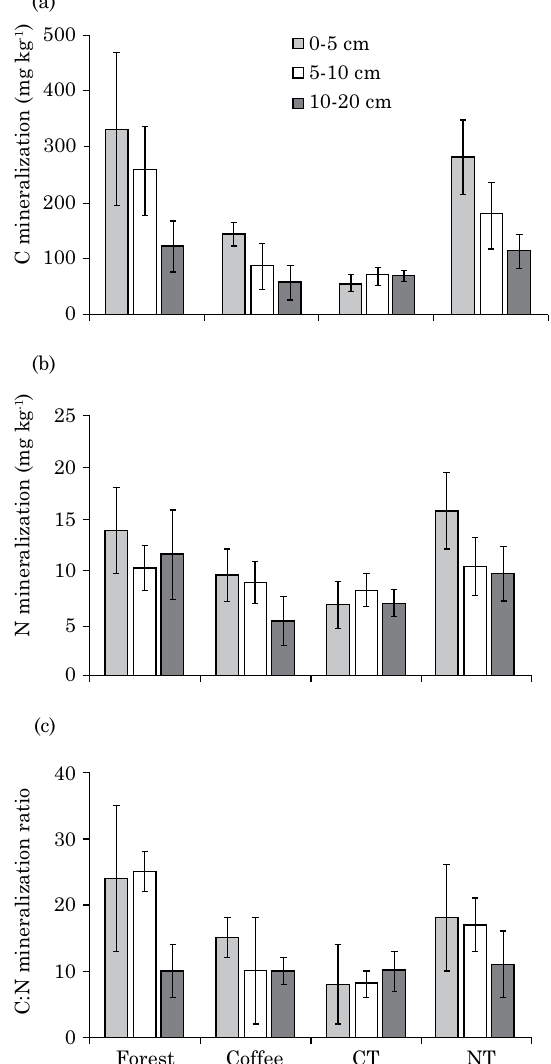
Figure 3. Metabolic quotient ( q Co 2 ) (a) and microbial carbon to organic carbon (C mic :C org ) ratio (b) of a Brazilian Oxisol after forest conversion to a perennial crop with coffee or annual grain crops (maize and soybeans) in conventional tillage or no-tillage from three layers (0-5, 5-10 and 10-20 cm). Average of three replications. Bars indicate standard deviation.